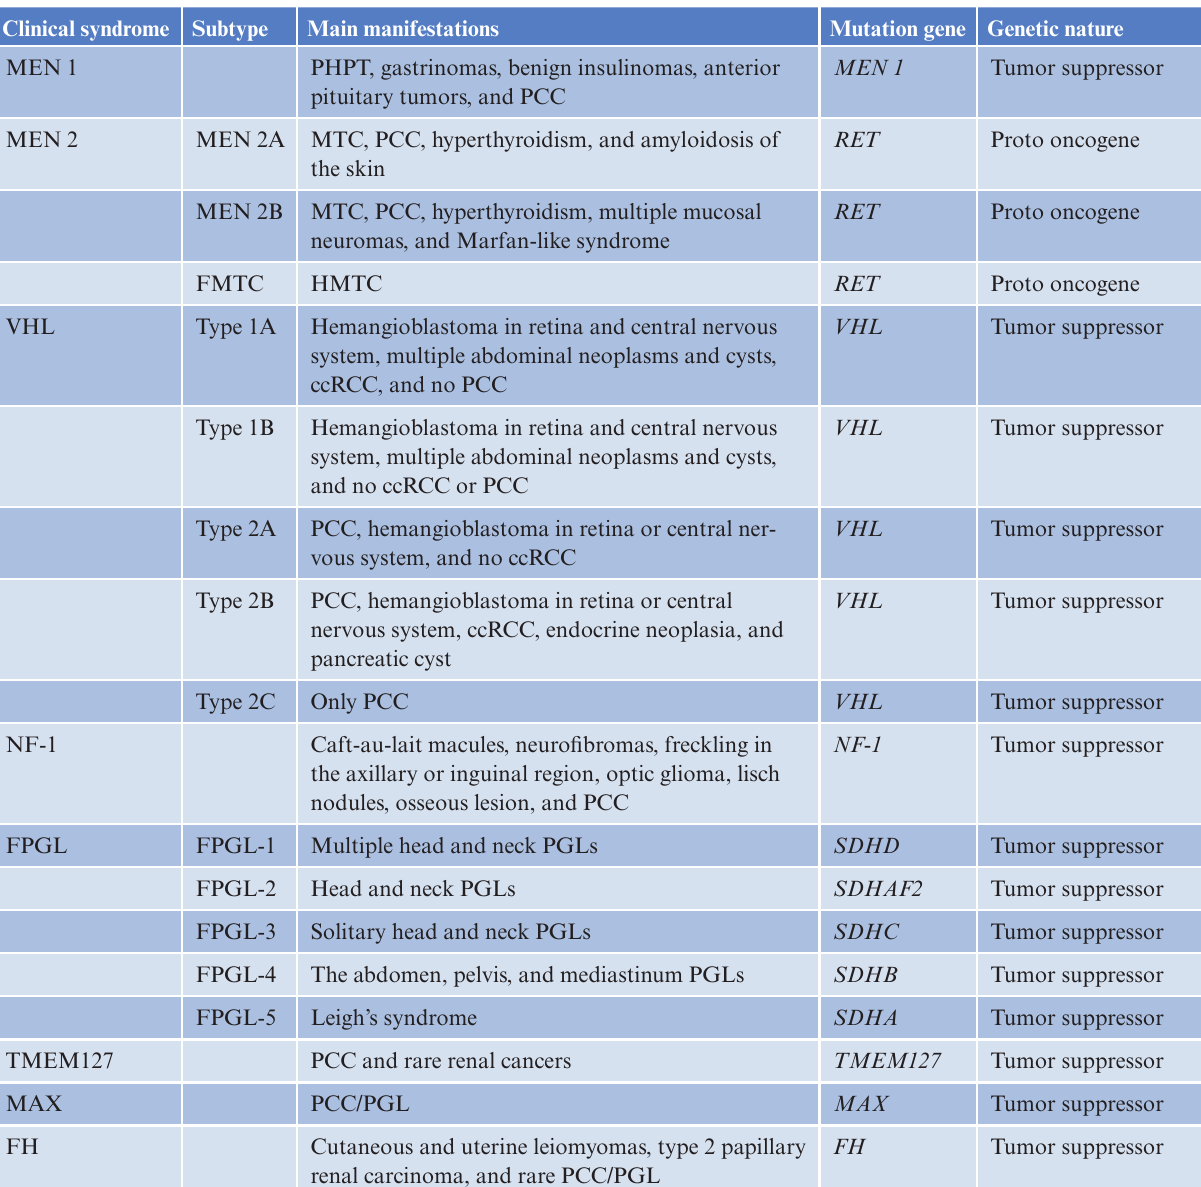
Table 1. PCC/PGL-related